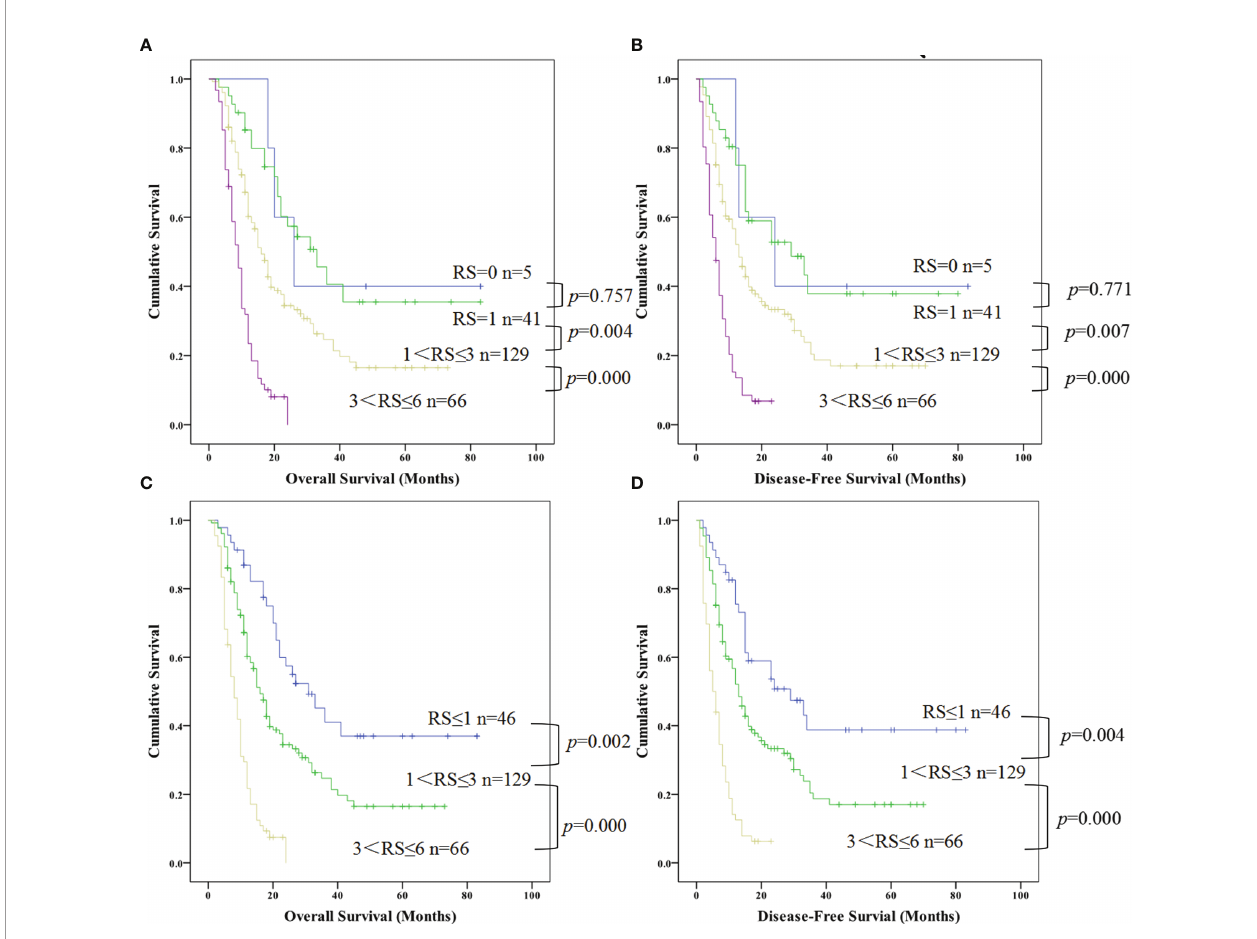
FIGURE 5 | Kaplan-Meier curve for overall survival and disease free survival of patients with advanced PDCA by risk scores (RS) based on multivariate cox proportional hazards model. (A, B) represented the survival difference from the low RS to high RS; (C, D) represented the survival difference in the re-grouped RS groups which combined RS=0 and RS=1 as a new group (PDAC, pancreatic ductal adenocarcinoma; RS, risk